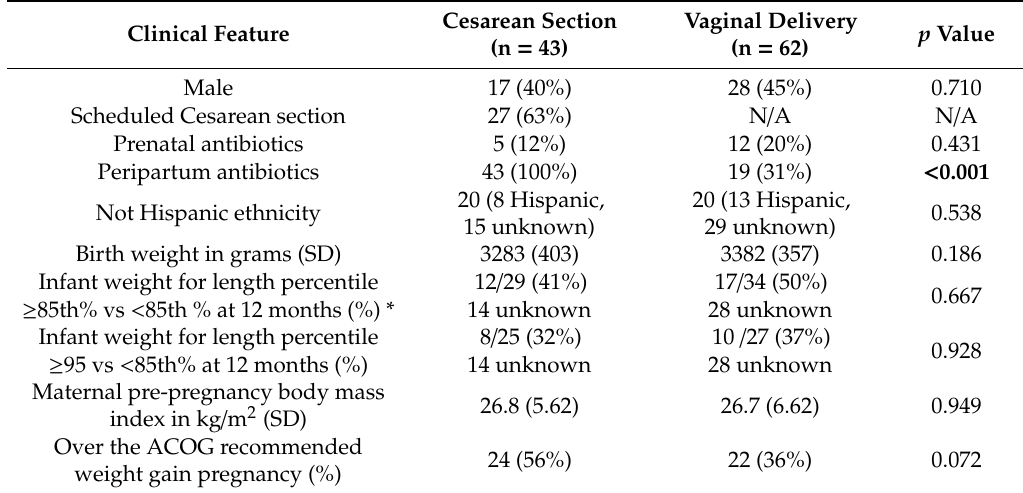
Table 1. Clinical features of infants by delivery